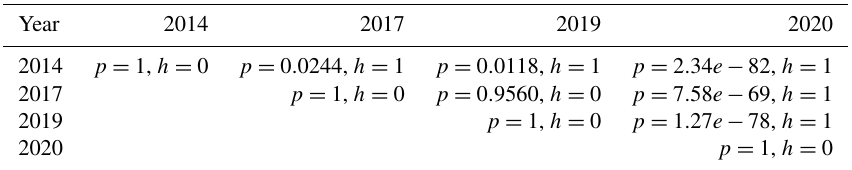
Table 5. Significance test, using the Mann–Whitney U test, for April in